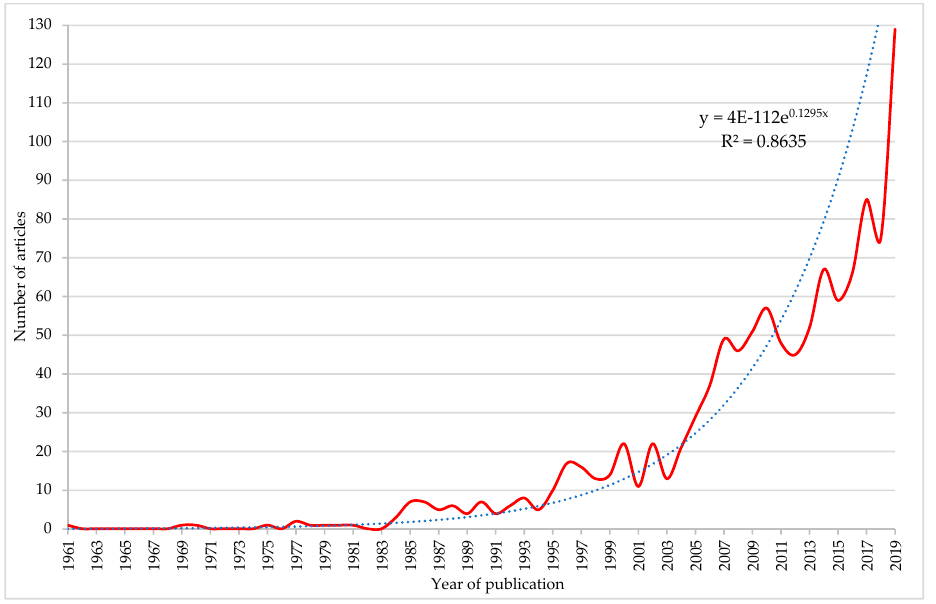
Figure 2. Number of articles by year and trend line (1961–2019).